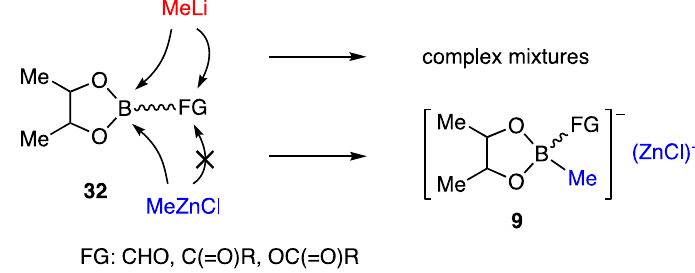
Table 2. Allylic coupling reaction with zinc phenylborates.